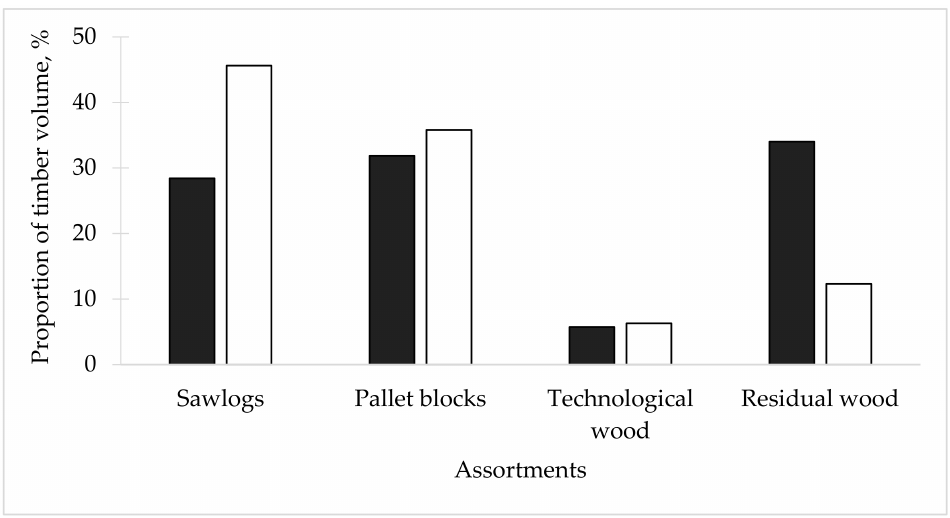
Figure 3. The proportion of assortment and residual wood volume for salvaged and undamaged trees ( n =